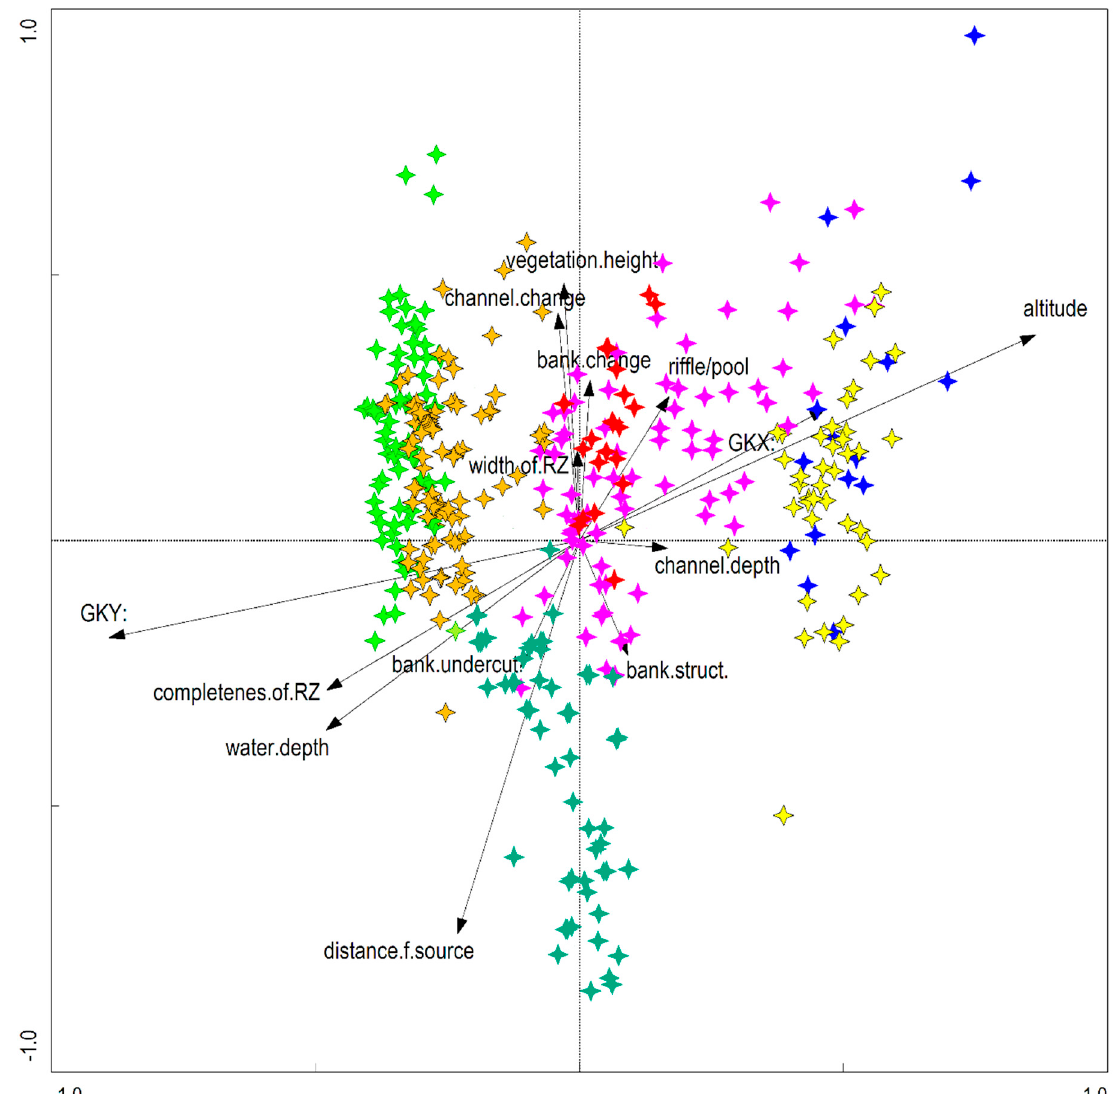
Figure 5. Canonical correspondence analysis ordination plot showing the distribution of the reaches with different abundances of IAS along the significant environmental parameters. Blue, Tržiška Bistrica River; yellow, Sora River; red, Ljubljanica River; pink, Savinja River; orange, Krka River; bright green, Sotla River; dark green, Sava River.